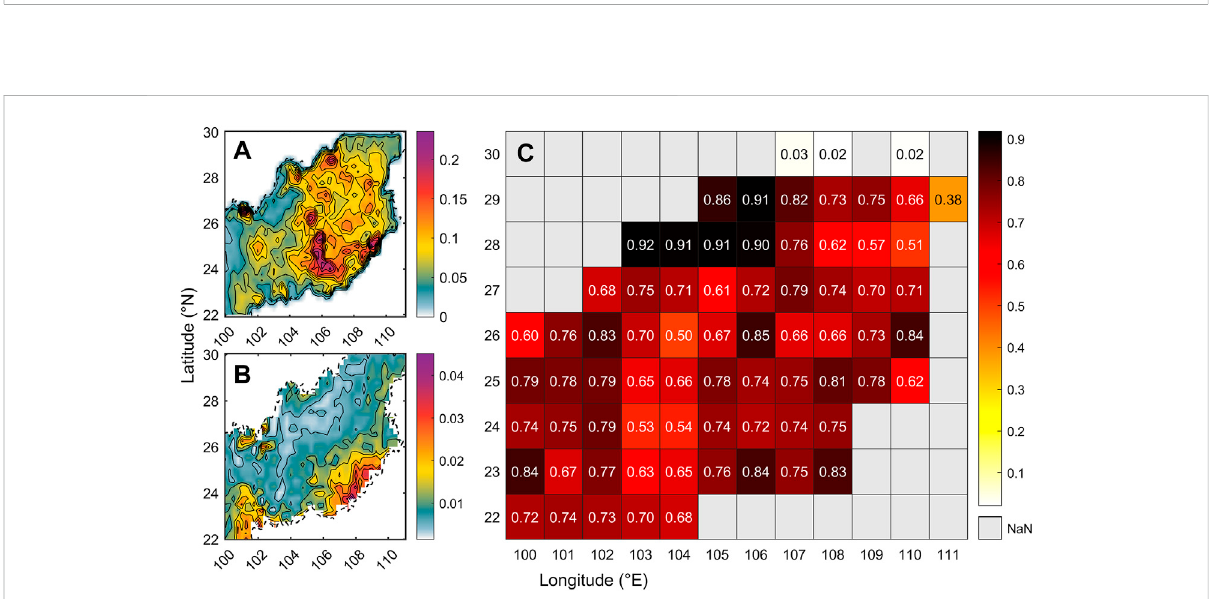
FIGURE 12 (A) The monthly spatial distribution of the lightning density ( fl · km − 2 · month − 1 ) on the Yungui Plateau from 2016 to 2020. (B) Same as (A) but for CAPE×P (J · kg − 1 · m − 1 · s − 1 ). (C) The spatial distribution of correlation coef fi cients between the spatial distribution of monthly density of lightning fl ashes and the spatial distribution of monthly CAPE×P in the 5 years. The spatial resolution is 1 ° × 1 °